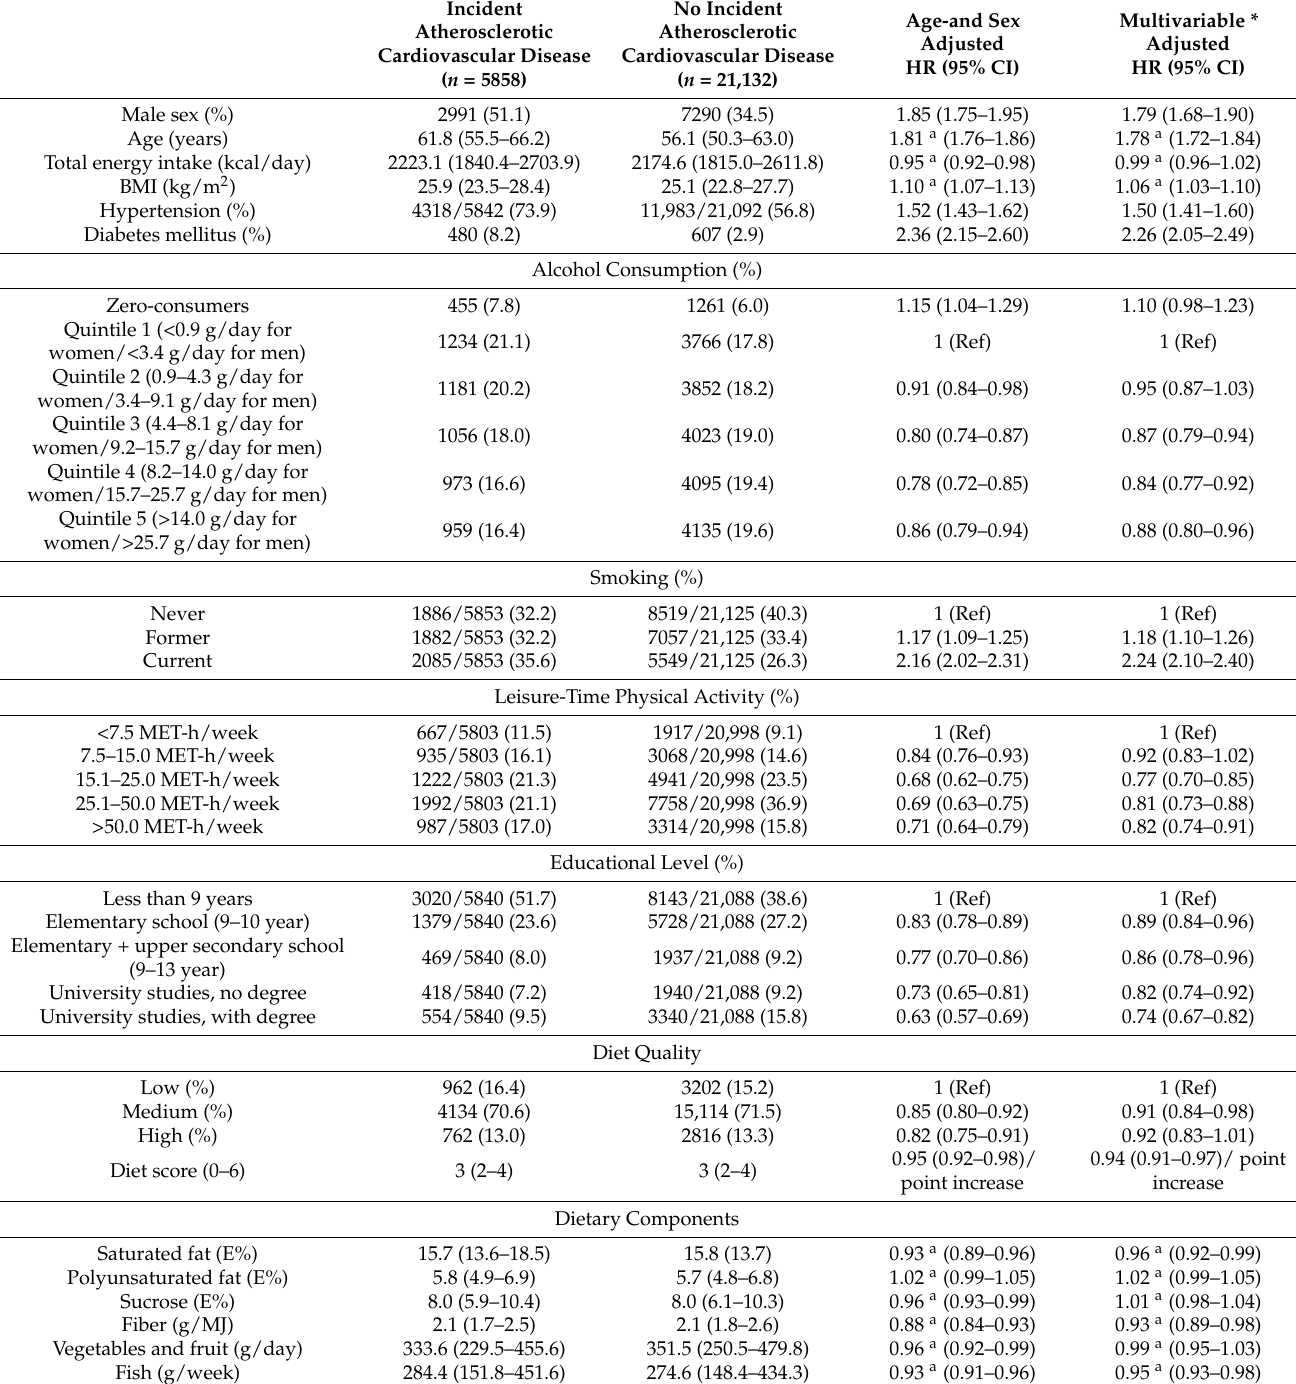
Table 1. Baseline characteristics of study participants with and without incident atherosclerotic cardiovascular disease in the MDCS